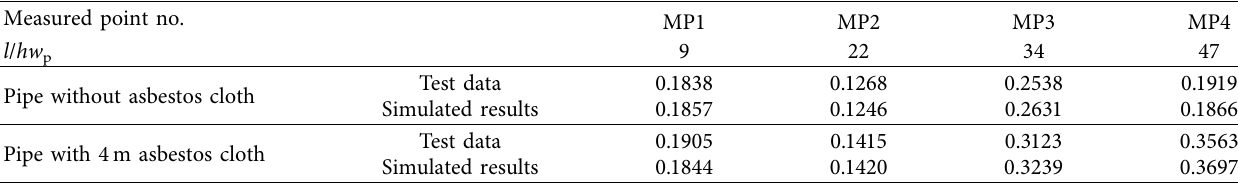
Table 2: Blast wave peak pressures in short pipe (1.01 × 10 5 Pa).